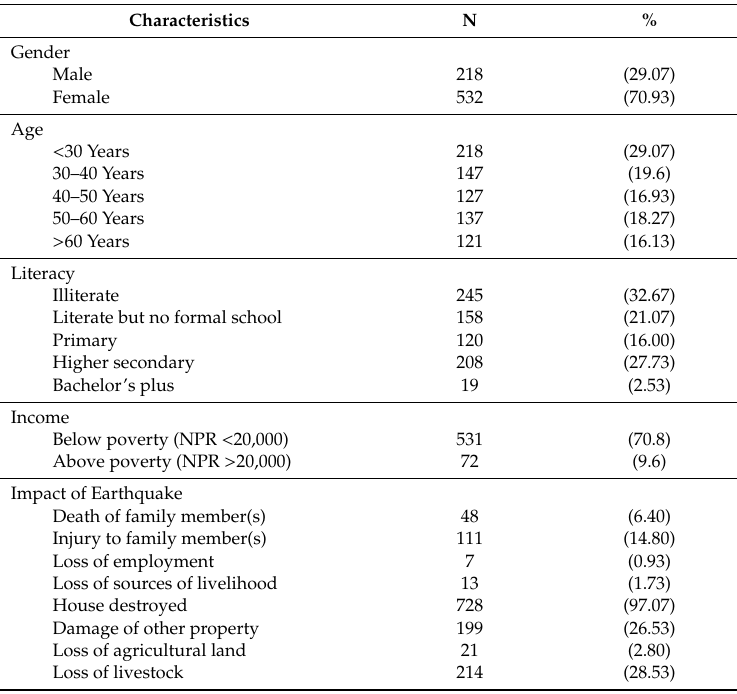
Table 1. Demographic